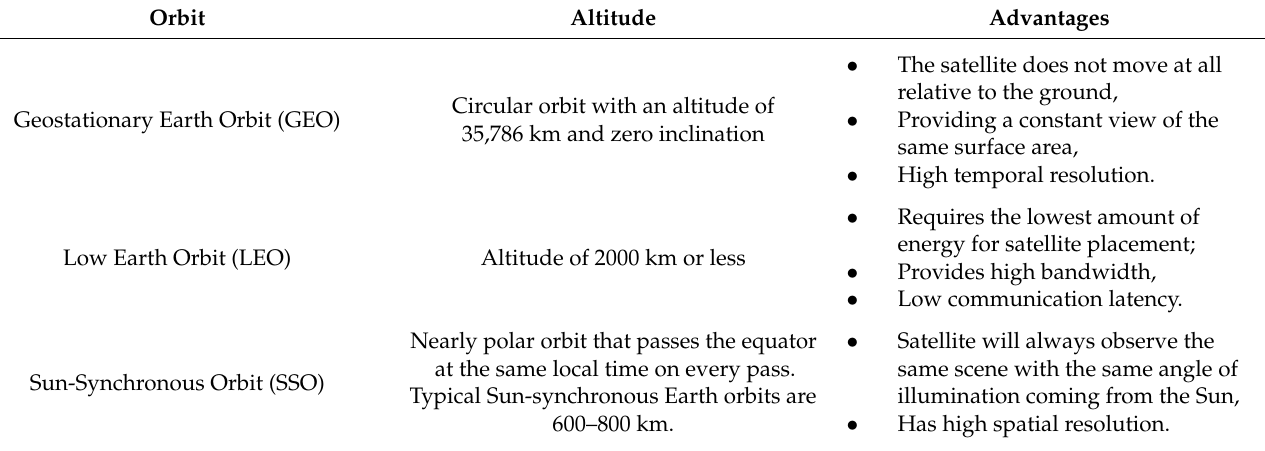
Table 1. Satellite categories, Adapted from